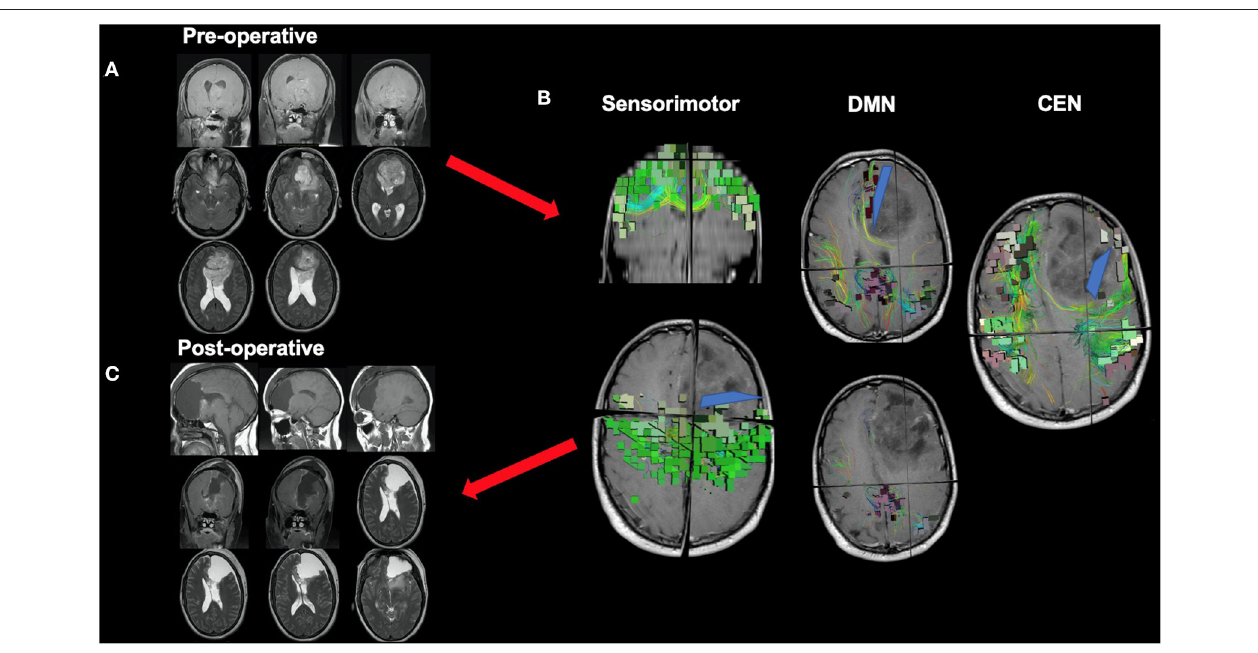
FIGURE 5 | Disconnection surgery. The neurosurgical community should move toward thinking of tumor surgery as a series of cortical and subcortical disconnections to minimize unnecessary network disturbances based on tumor location and patient goals. This figure presents a case of a medial anterior, left frontal glioma which demonstrates complex relationships with adjacent anatomy, such as the corpus collosum and falx cerebri. (A) While a complex case, it can be reduced to a series of disconnections that can be defined against three known brain networks: the DMN on medial boundary, the CEN on the lateral boundary, and the sensorimotor network on the posterior boundary. (B) Understanding information on the spatial relationship of the tumor to relevant white matter tracts and major networks can allow the neurosurgeon to make more informed decisions during surgery, such as where or how far to disconnect (blue lines) normal tissue infiltrated by a tumor up until certain key fibers or nodes are met. This decision should be made based on patient pre-defined goals and patient prognosis among other factors, and further work will hopefully clarify how much of specific networks can be safely disconnected without compromising certain functions (C)